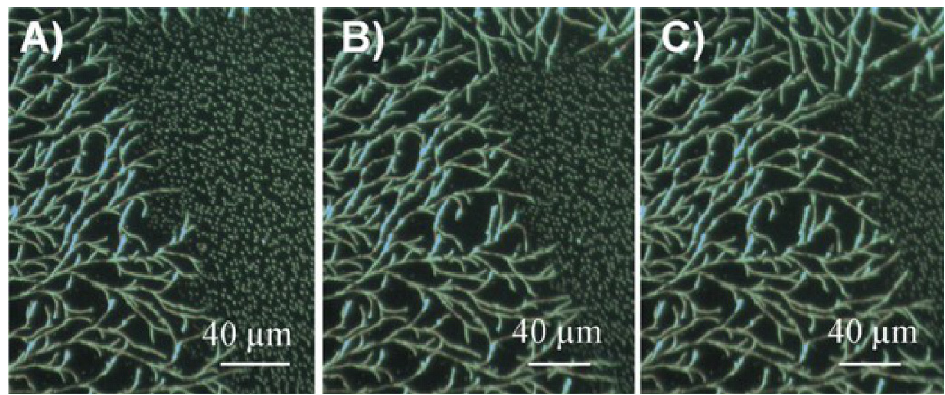
Figure 4. Dendrite growth of PETN on silicon substrate as a function of time. A) t